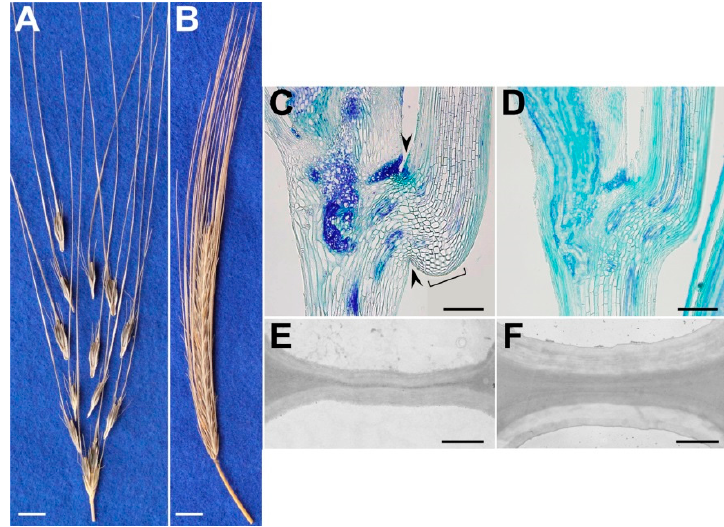
Figure 3. ( A , B ) Representative mature spikes of wild barley accession OUH602 ( A ; brittle) and induced non-brittle rachis mutant M96-1 ( B ). ( C , D ) Representative longitudinal sections of junction between two rachis nodes at the anthesis stage, stained with toluidine blue O. Arrowheads: separation layer (or ‘constriction groove’); square bracket: layer of expanded cells. ( E , F ) Representative transmission electron microscopy showing cell-wall thickness in separation layer of wild ( E ) and shattering-resistant mutant ( F ) spikes prior to disarticulation. Scale bars: 1 cm ( A , B ); 250 µm, ( C , D ); 1 µm, ( E , F ) (reproduced with permission from Pourkheirandish et al. [14]; with modifications).